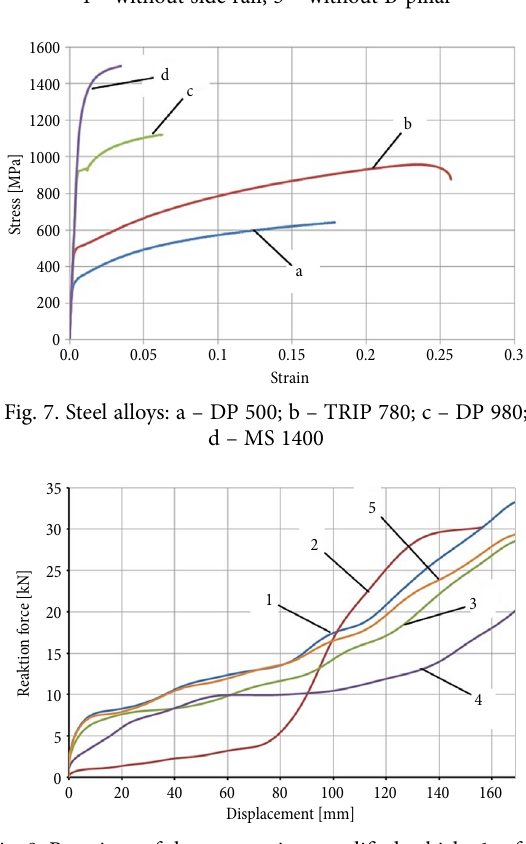
Fig. 8. Reactions of the support in a modified vehicle: 1 – full structure; 2 – without A-pillar; 3 – without front header; 4 – without side rail; 5 – without B-pillar